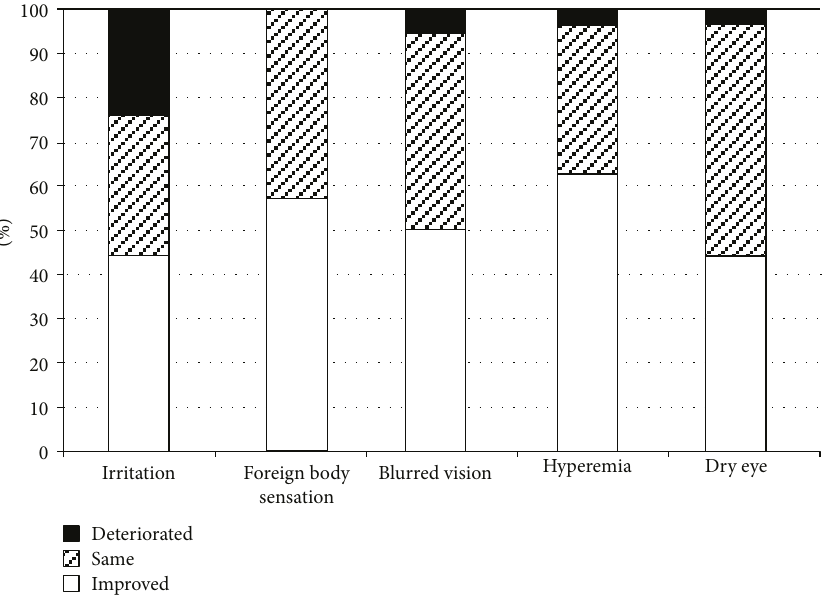
Figure 7: Survey one month after fi xed-combination therapy introduction.